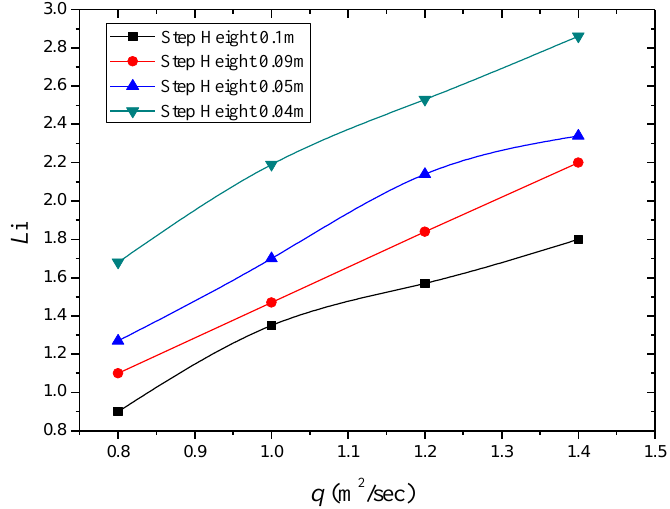
Figure 5. Variation of inception length ( Li ) with discharge rate at different step heights of flat stepped spillway models.